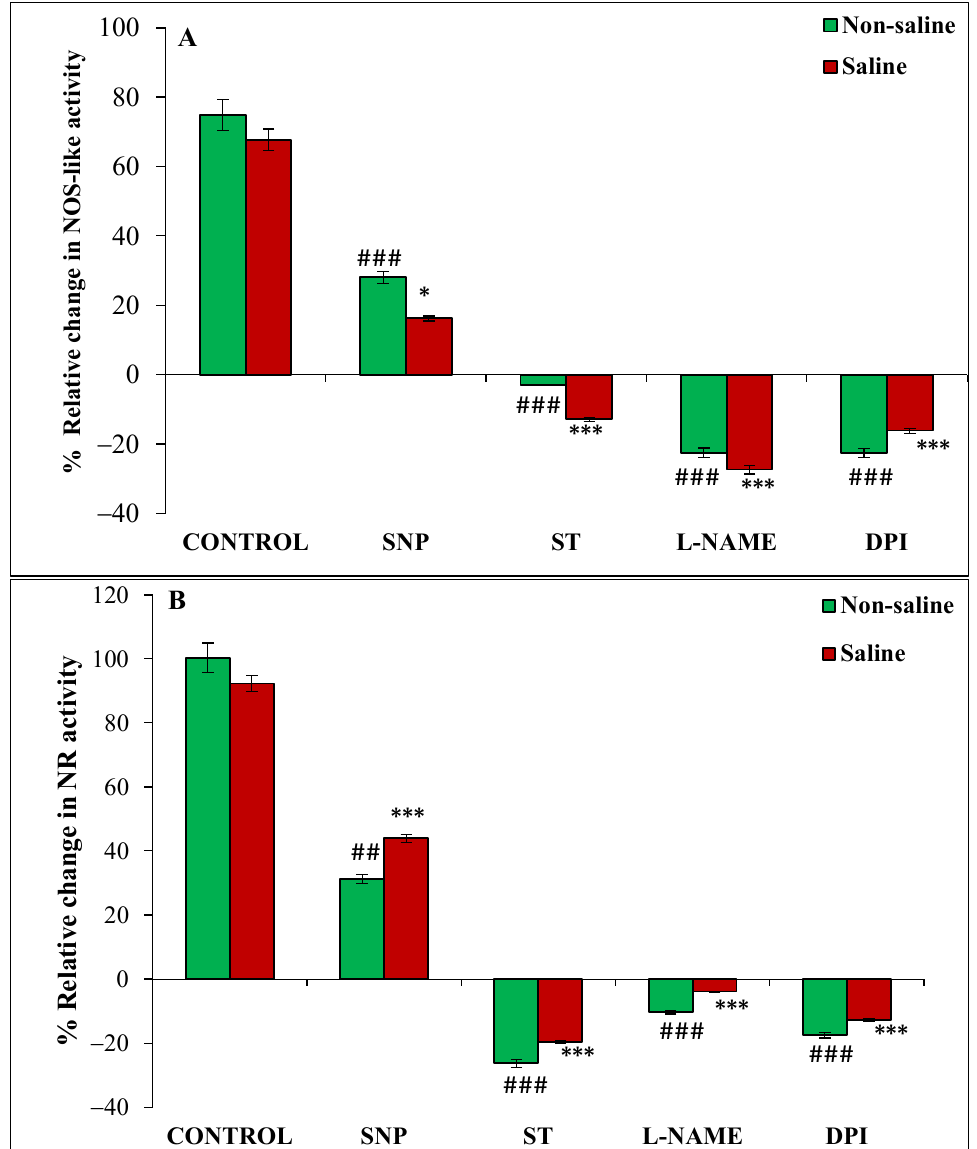
Figure 5. Relative change (%) in NOS-like ( A ) and NR ( B ) activities of magnetoprimed over unprimed seeds kept for 24 h in different modulators of NO and ROS production under non-saline and saline conditions. The data are represented as mean values of relative change ± SE (n = 3). ### p < 0.001, ## p < 0.01 shows significant difference amongst the relative change in the seeds grown in control with the seeds grown in different modulators of NO/ROS production under non-saline conditions; *** p < 0.001, * p < 0.05 shows significant difference amongst the relative change in the seeds grown in control with the seeds grown in different modulators of NO/ROS production under saline conditions.